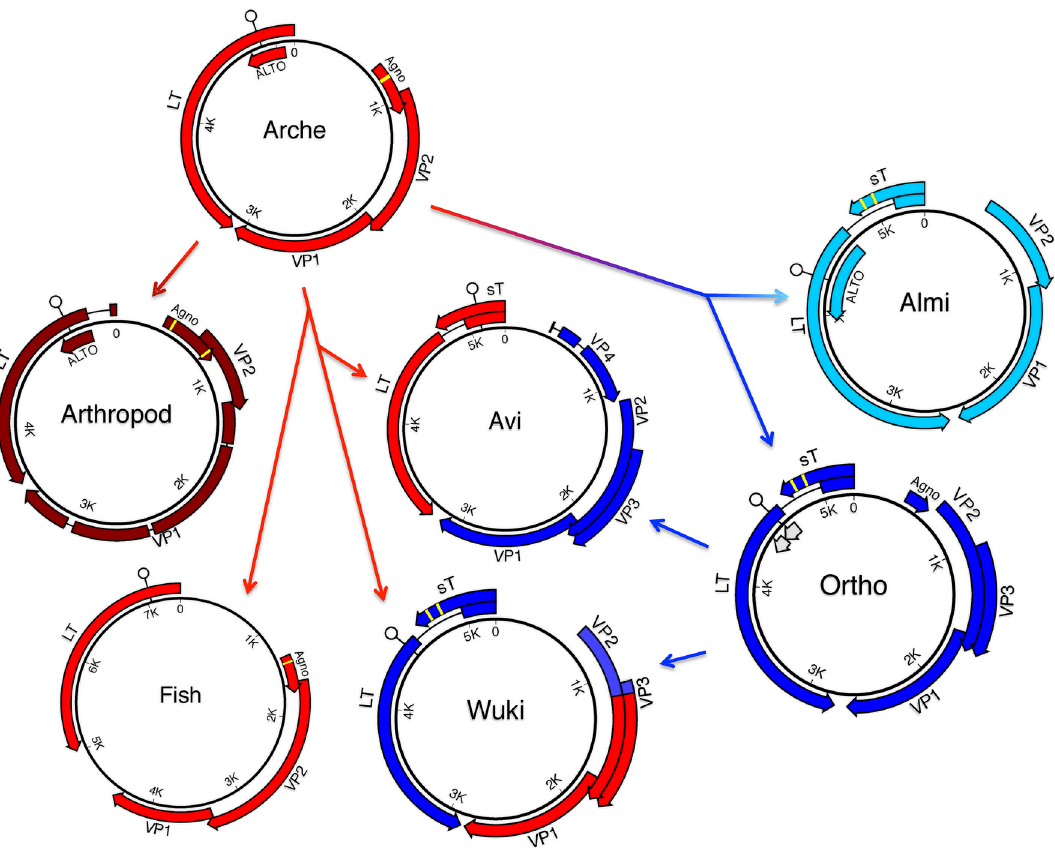
Fig 5. A hypothetical framework for ancient recombination events among major polyomavirus clades. The model attempts to reconcile observed incongruities between LT and VP1 phylogenetic trees shown in Figs 3 and 4. In the model, a hypothetical ancient polyomavirus, designated Arche, is inferred to have infected the last common ancestor of bilaterian animals. The ancient Arche lineage then gave rise to separate polyomavirus lineages found in arthropods and fish, as well as the mammalian Ortho/Almi lineages. The figure depicts Avi and Wuki clades arising after recombination events involving an unknown vertebrate-Arche lineage and Ortho-like species. The figure does not depict the inferred evolution of the HPyV6/7 clade, which appears to have arisen after a separate recombination event involving the late region of a hypothetical vertebrate-Arche lineage and the early region of a basal Almi-like species. The TSV lineage, which shows evidence of recombination between the Ortho and Almi lineages, is also omitted. White lollipops represent predicted pRb-binding motifs (LXCXE or related sequences). Yellow bars represent hypothetical metal-binding motifs (CXCXXC or related sequences). The absence of metal-binding motifs in Avi small T antigen (sT) proteins suggests a different evolutionary origin than the classic metal-binding Ortho/Almi sT. Possible ALTO-like ORFs predicted for some Ortho species are shaded